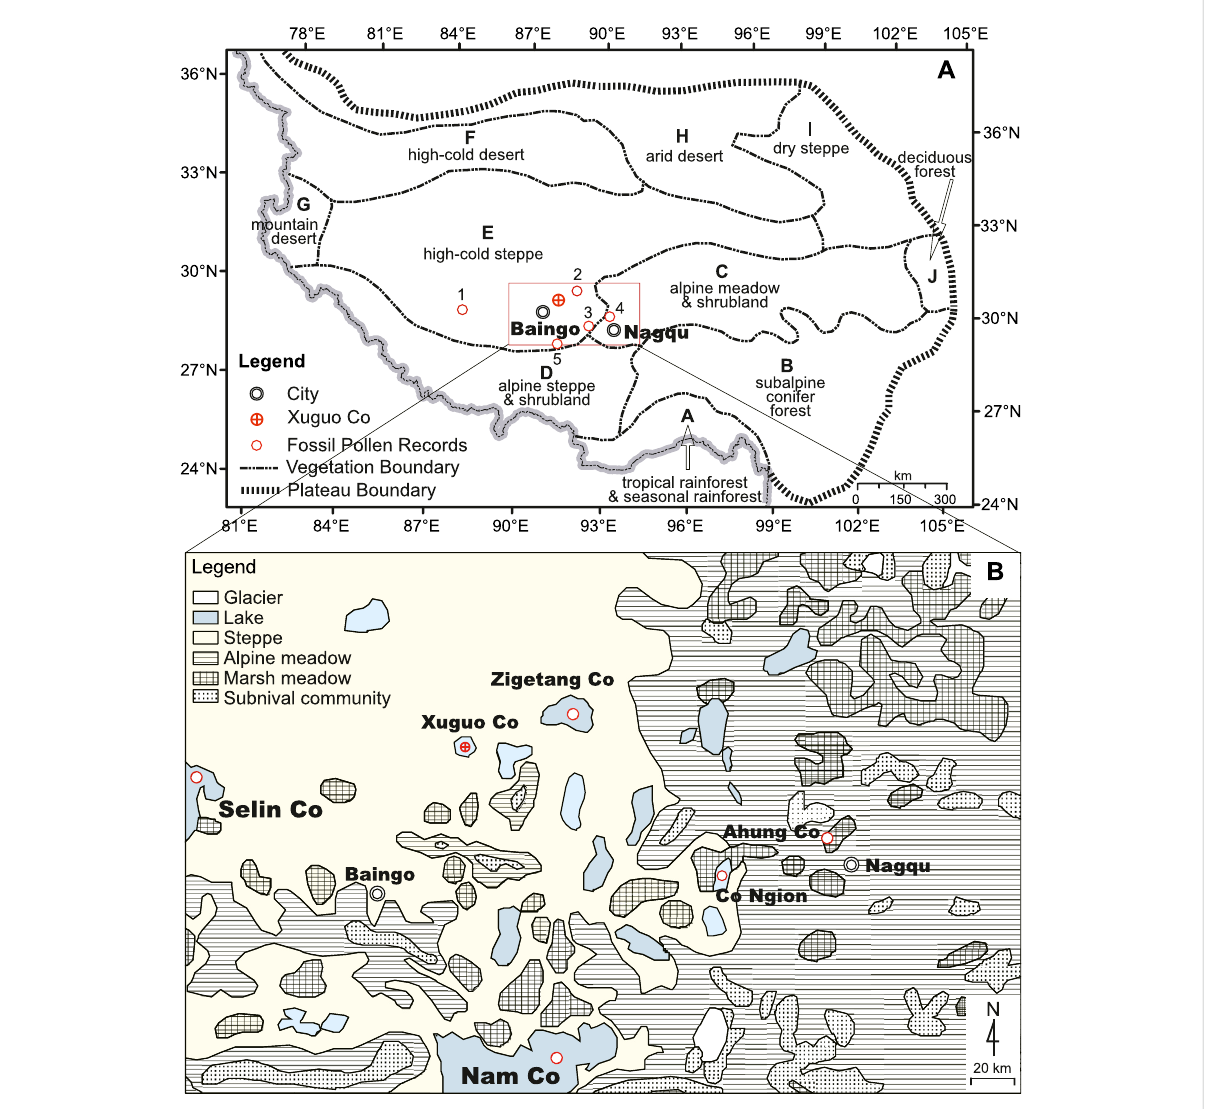
FIGURE 1 (A) MapoftheTibetanPlateaushowingthevegetation,locations ofXuguoCo,andmainfossilrecordscitedinthisstudy(1.SelinCo;2.Zigetang Co; 3. Co Ngion; 4. Ahung Co; 5. Nam Co). (B) Regional vegetation in the central Tibetan